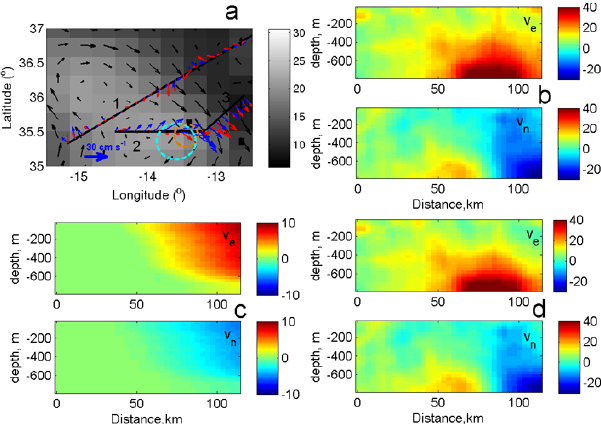
Fig. 3. (a) Velocity magnitude (cms − 1 ) along transect 2 for each of the ADCP bins, after the AzC is removed. Black: 40–100m levels; red: 130–200m; cyan: 230–300m; magenta: 320–500m; green: 510–610m; and blue: 650–800m. The vertically aligned black dashes identify the centres of the meddy (upper line) and of its surface signal (lower line). (b) Maximum azimuthal velocity of the eddy ( V az , cms − 1 , green line), zonal distances of the eddy centre relative to the western tip of transect 2 ( x c , km, black line), merid- ional distances of the eddy centre relative to mean meridional posi- tion of transect 2 ( y c , km, red lines), and the dynamic radius of the eddy ( R , km, blue lines). The dashed and dotted lines are the esti- mates of the corresponding parameters using only western or only eastern maximum of current velocity; solid lines are the means of the previous two. Straight, vertical dotted lines of the corresponding colour are given as a reference